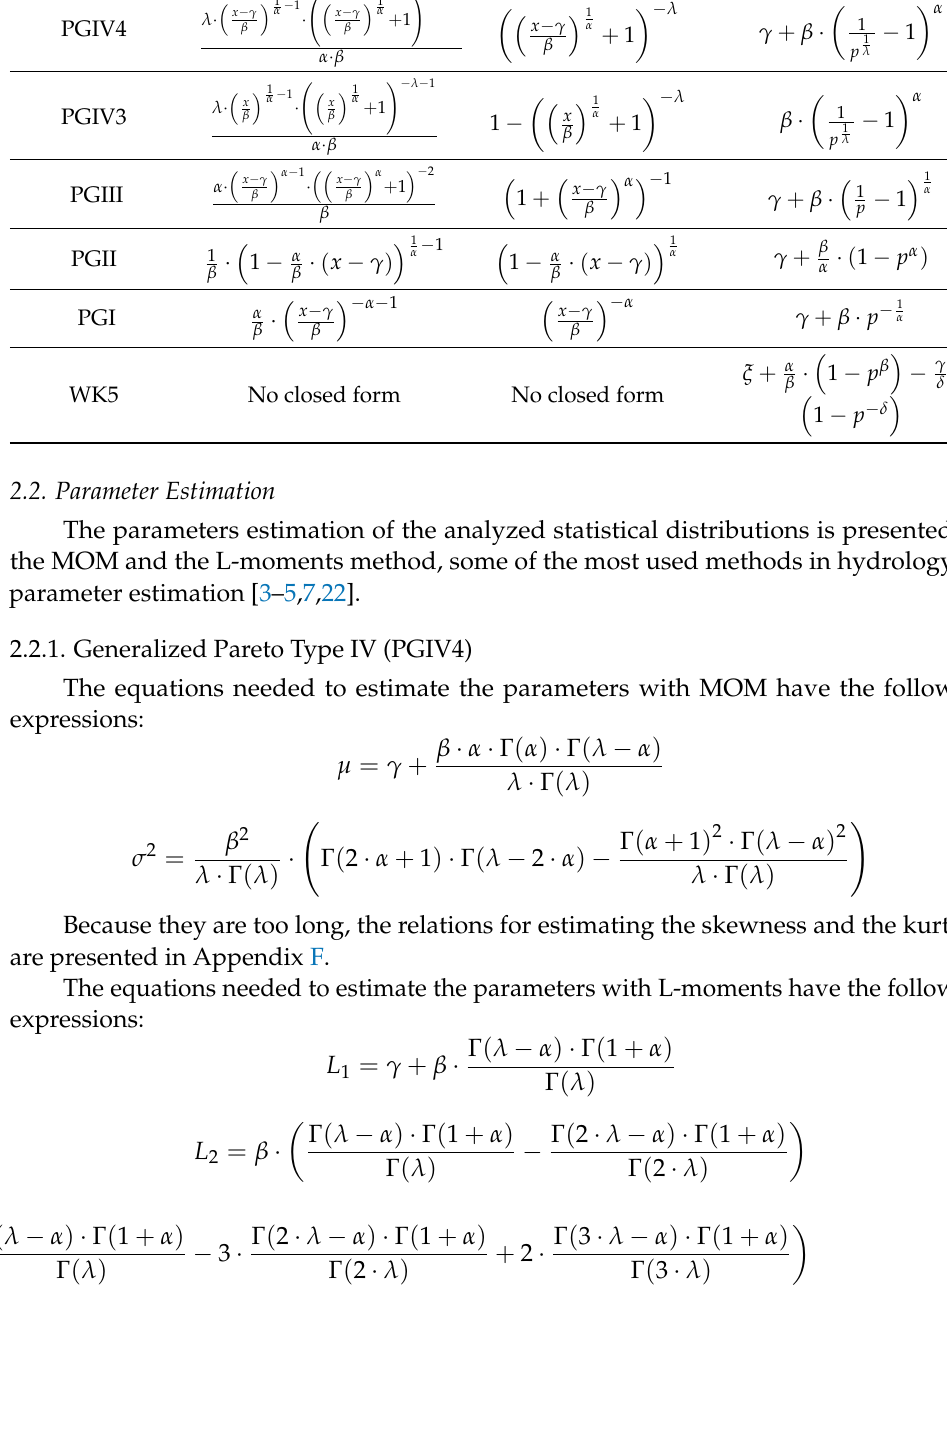
Table 2. The analyzed probability distributions.